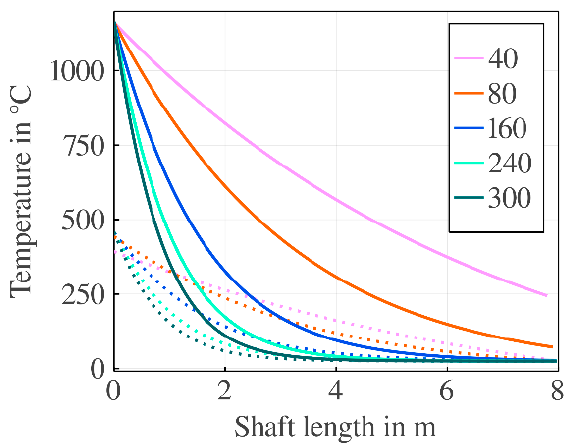
Figure 12. Simulated scrap bulk (S3) temperature and off-gas temperature over the length of the shaft for different cell sizes after 50 min; dotted = scrap temperature, solid = off-gas temperature.